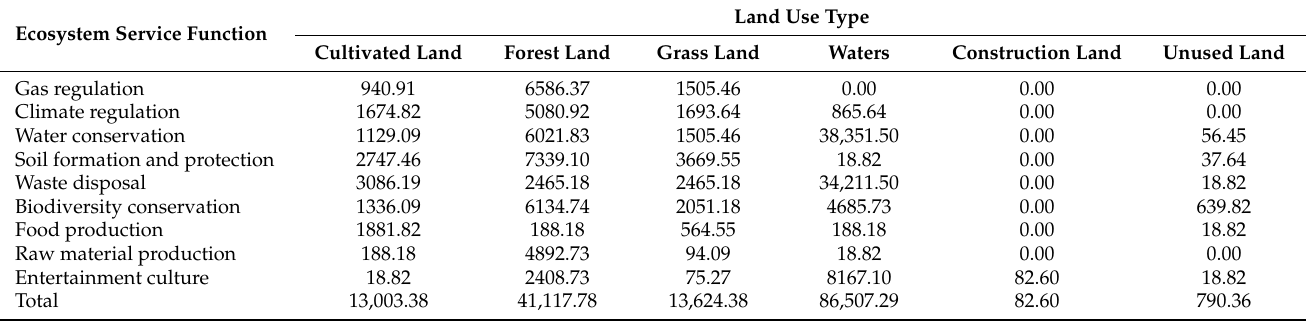
Table 1. ESV Coefficient for the Lower Reaches of the Tarim River/yuan · hm − 2 . Ecosystem Service